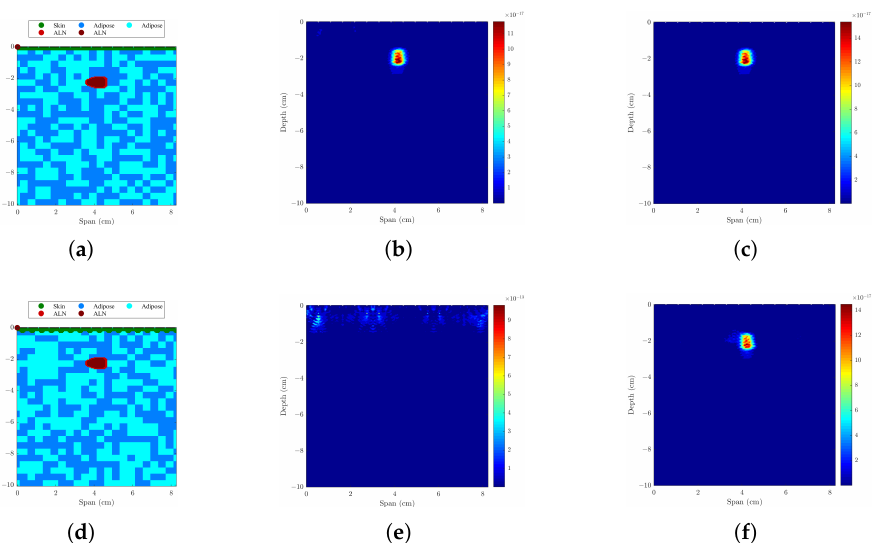
Figure 3. Models and the corresponding backscattered energy results from the implemented MWI system of an axillary region model with only one ALN and a ( a – c ) uniform skin layer or a ( d – f ) sinusoidal skin layer. The figure shows the simulated models in ( a ,textbfd), and the cor- responding backscattered energy results using the CR-DMAS beamformer in ( b , e ), and ( c , f ) after applying Li’s and Bond’s artifact removal algorithm, respectively. The high intensity regions in ( b , c , e , f ) indicate the detection of the lymph node.